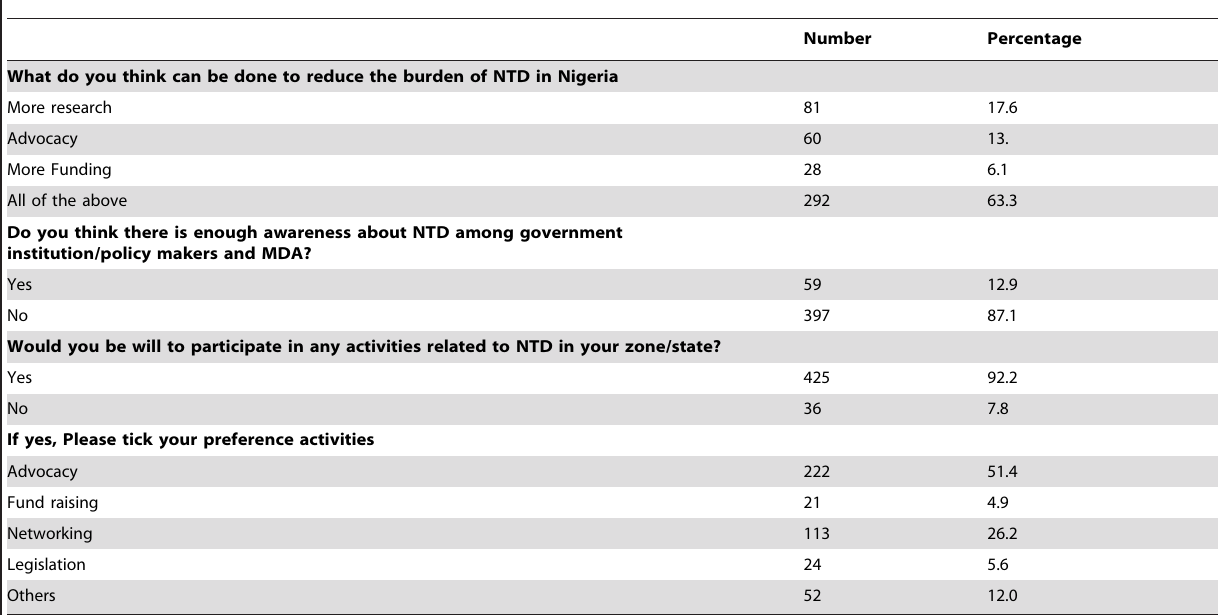
Table 5. Different opinions of the public about NTDs control